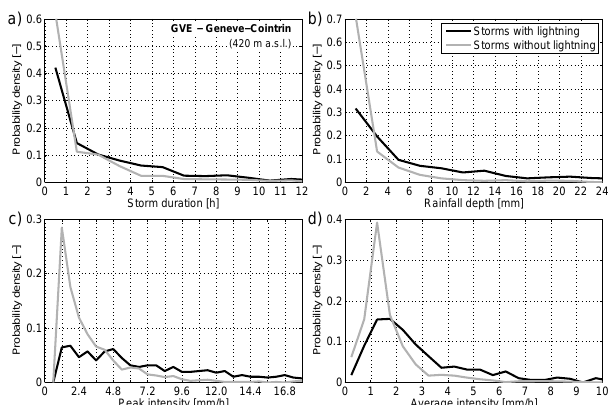
Fig. 5. Empirical probability density functions (PDFs) for the main storm properties: (a) storm duration D , (b) total rainfall depth R , (c) peak intensity I p , and (d) average storm intensity I a , differenti- ated by lightning, for station